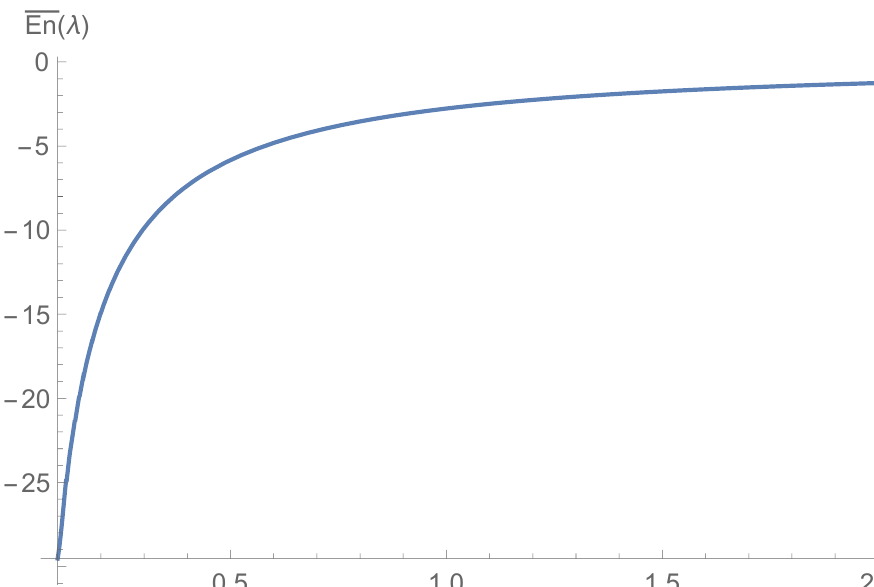
Figure 23. Average energy for free Lorentzian subluminal particles with high | λ |